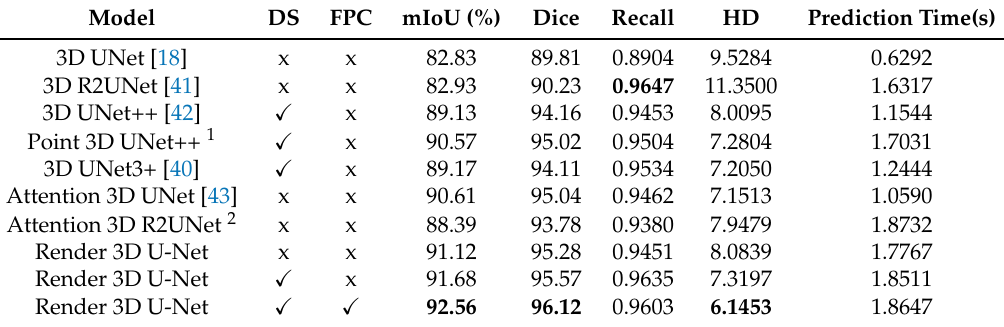
Table 4. Heart segmentation performance results on the SegTHOR test dataset.